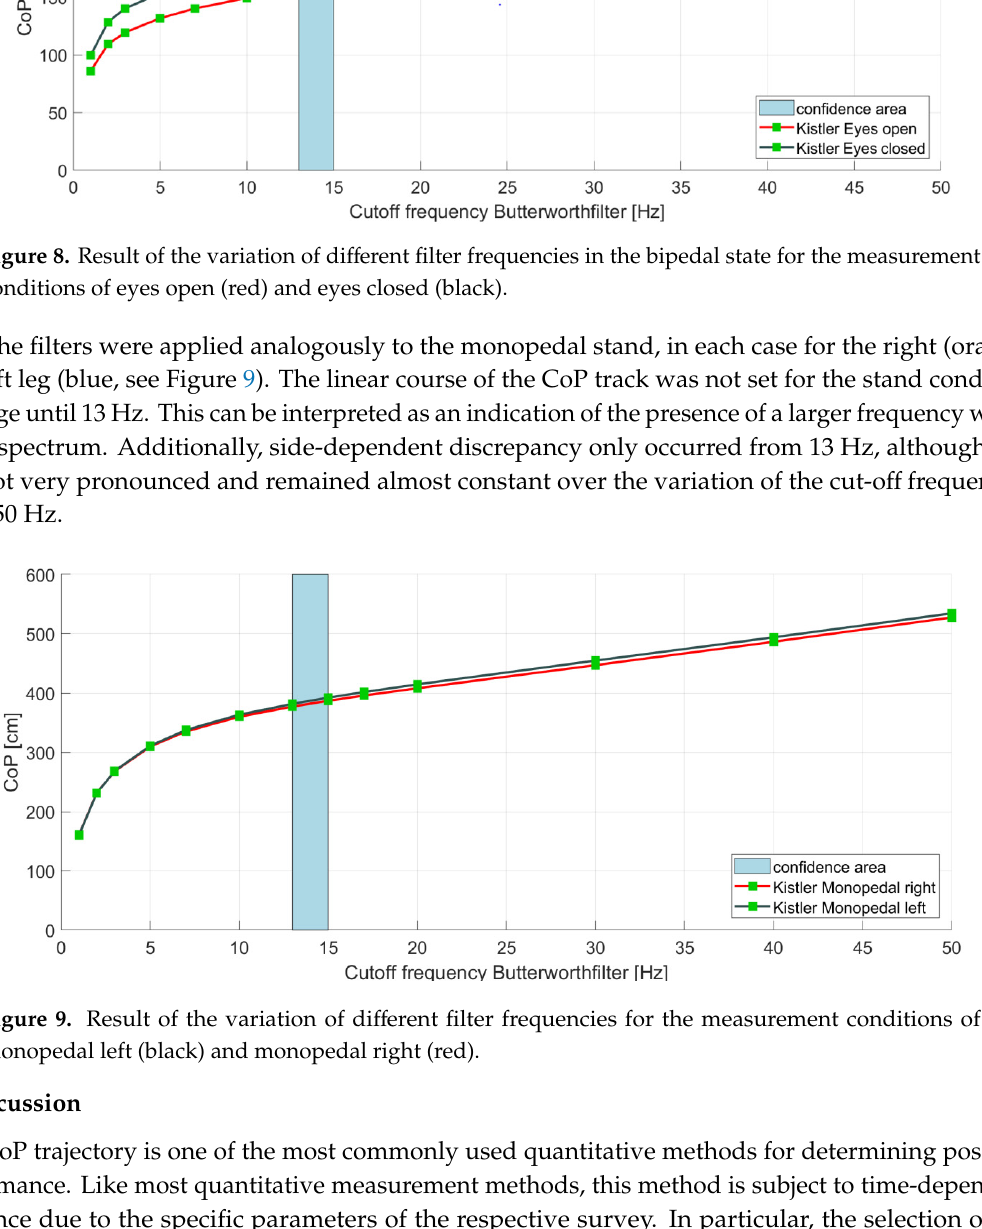
Figure 9. Result of the variation of different filter frequencies for the measurement conditions of monopedal left (black) and monopedal right (red).